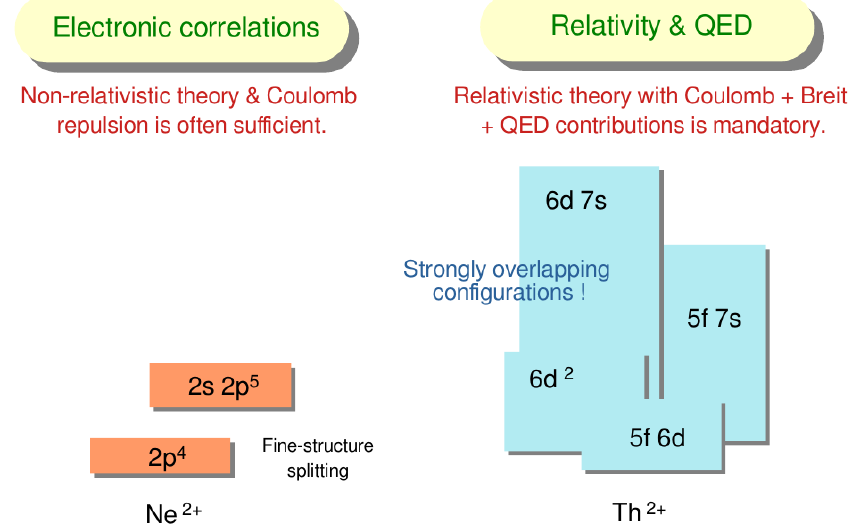
Figure 1. A simple man’s view of the fine-structure of open-shell atoms and ions. For light elements, such as Ne 2 + with a 2 p 4 ground configuration, the excitation of a valence-shell electron leads to levels that are energetically well separated, and whose configurations can be treated rather independently. For open d - and f -shell elements, in contrast, many configurations overlap with each other, and this even applies for the ground configuration. While the 2 p 4 fine-structure of Ne 2 + is well separated by ∼ 200,000 cm − 1 from the 2 s 2 p 5 configuration, the 5 f 6 d ground configuration of Th 2 + ‘overlaps’ with the fine-structure levels of several and both, odd- and even-parity configurations. For any detailed ab-initio calculations, therefore, electronic correlations as well as relativistic and QED contributions need always to be taken into account for a quite large number of